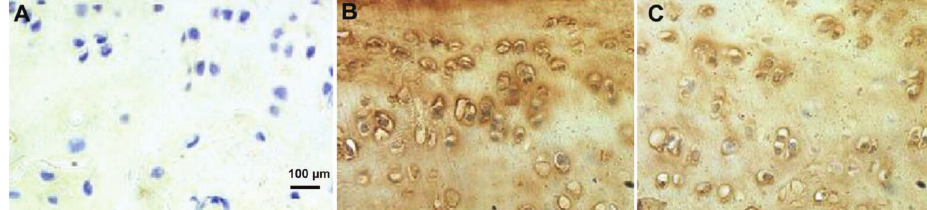
Figure 4. Immunohistochemical analysis of anti-tumor necrosis factor- a antibody (ATNF) effects on matrix metalloproteinase (MMP)-13 in cartilage lesions (original magni fi cation 400 (cid:2) ). A , Staining for MMP-13 is less detectable in the sham-operated (SP) group. B , In the anterior cruciate ligament transection (ACLT) + normal saline (NS) group, MMP-13 expression is found throughout the articular cartilage. C , In the ACLT + ATNF group, MMP-13 is mainly detected in chondrocytes at and close to the articular